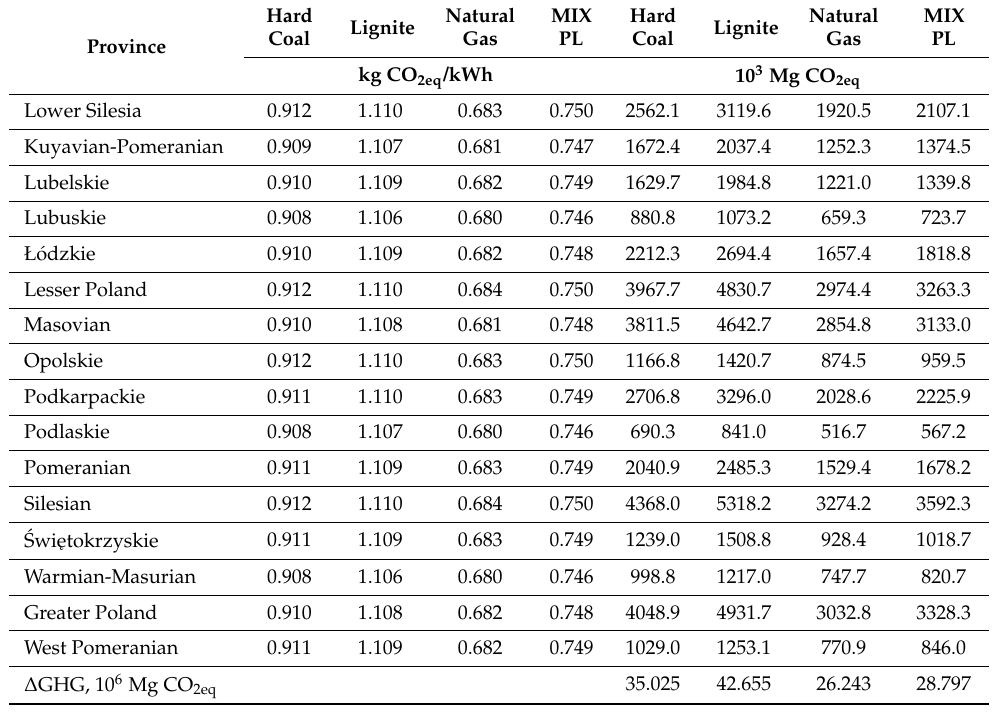
Table 4. ∆ GHG, Mg CO 2eq , calculated for provinces in Poland in 30 years perspective on the basis of individual GWP differences for the energy sources considered to be replaced, kg CO 2eq /kWh.